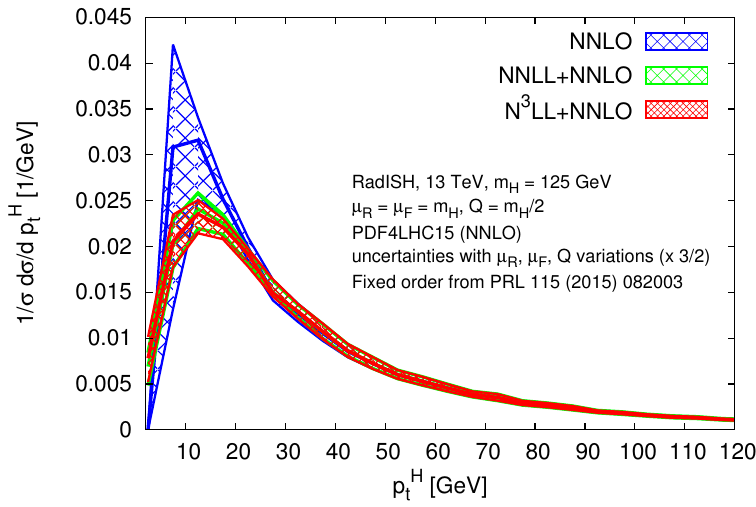
Figure 4 . Comparison among the matched normalised distributions at N 3 LL+NNLO, NNLL+NNLO, and NNLO. The uncertainties are obtained as described in the